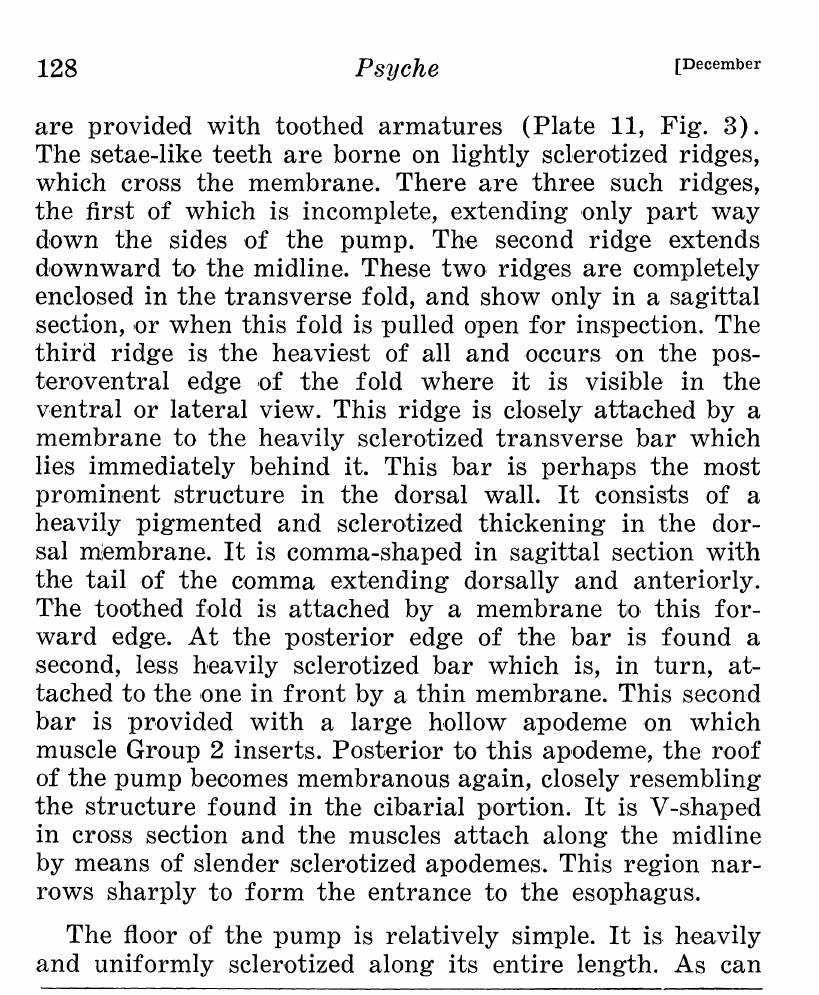
Figure 1. Ventral view of the food and salivary pumps of Pelocoris. Figure 2. Lateral view of the food pump of Notonecta with the lateral wall of the floor of the pump cut avay. Figure 3. Ventral aspect of the roof of the food pump of Pelocoris showing the transverse fold and the teeth. Figure 4. Lateral view of the food pump of Pelocoris with the lateral wall of the pump cut away. Figure 5. Ventral view of the roof of the pump of Pelocoris showing the armature and the lateral fold. Figure 6. Dorsal aspect of the roof of the pump of Notonecta. Figure 7. Dorsal aspect of the roof of the pump of